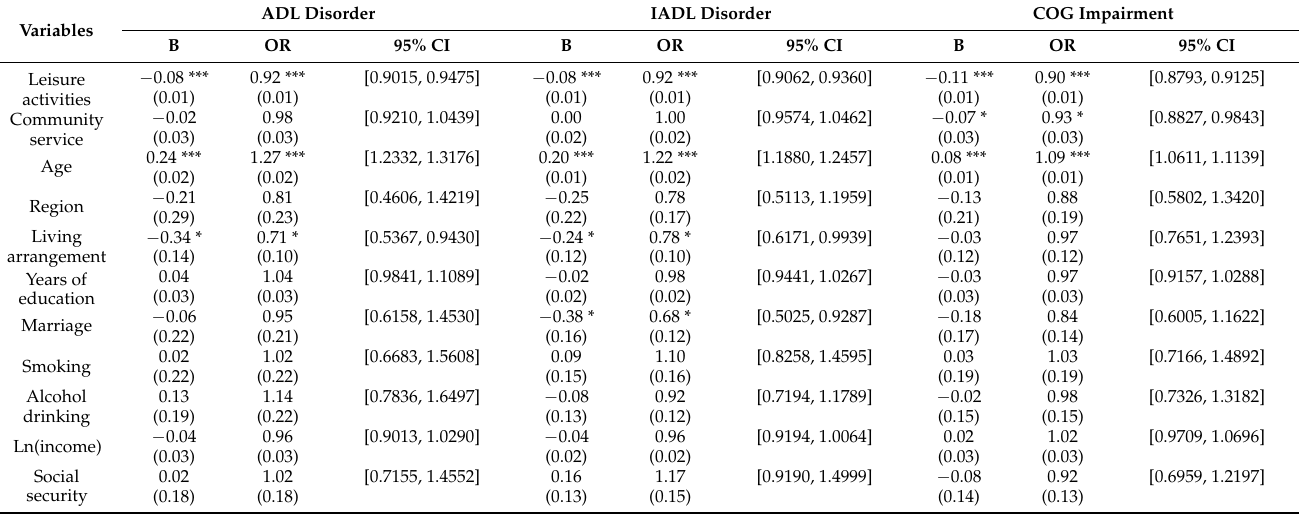
Table 4. The effect of leisure activities on ADL disorder, IADL disorder, and cognitive